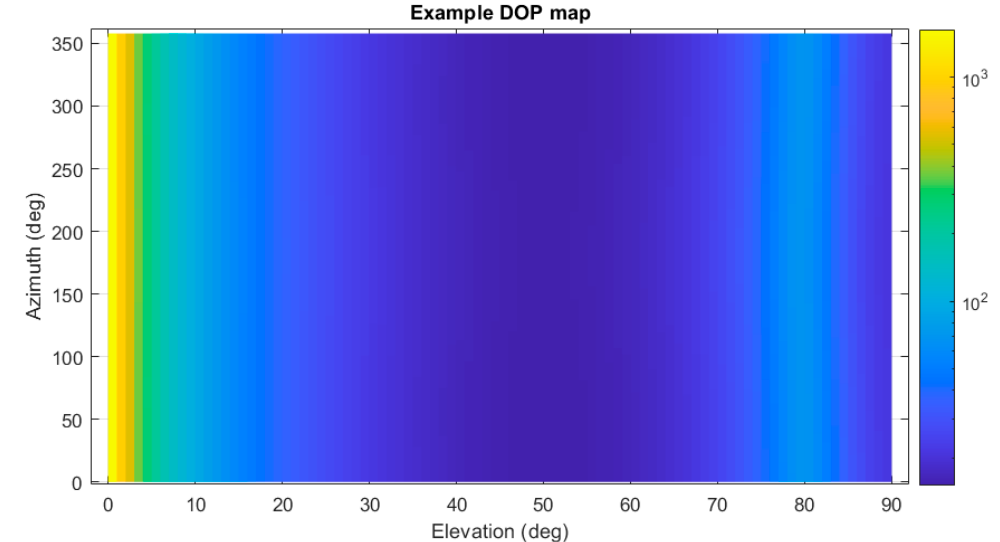
Figure 2. Example DOP map for a 550 km high satellite, stations located on a circle at 100 km of distance.